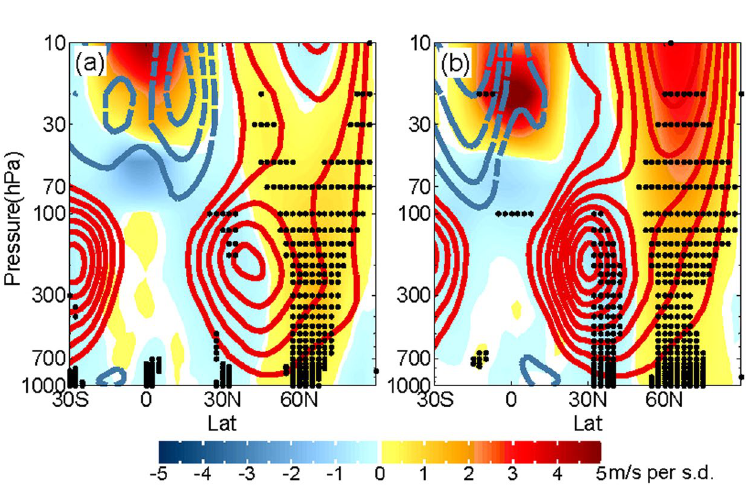
Figure 4. ( a ) October and ( b ) DJF-mean zonal mean zonal wind regressed onto the October Z70 hPa PC2 (shaded; in m/s per standard deviation of this PC), compared with climatological mean states (contours with an interval of 5 m/s; positive/negative values in red/blue, respectively). The black dots indicate the 95% confidence interval of the regression based on a two-tailed t